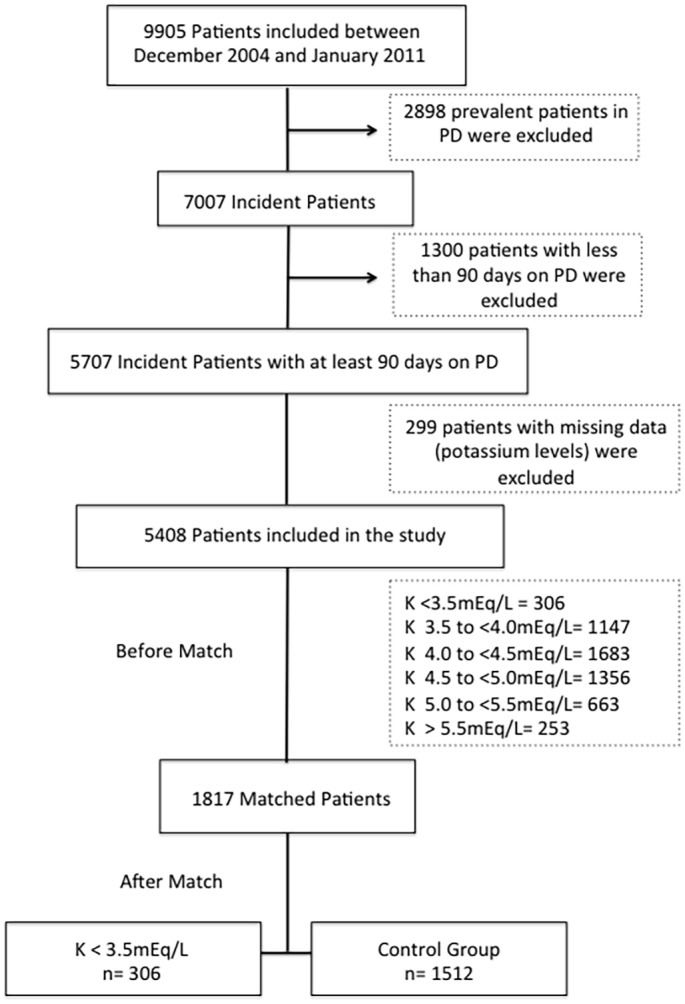
Study population.